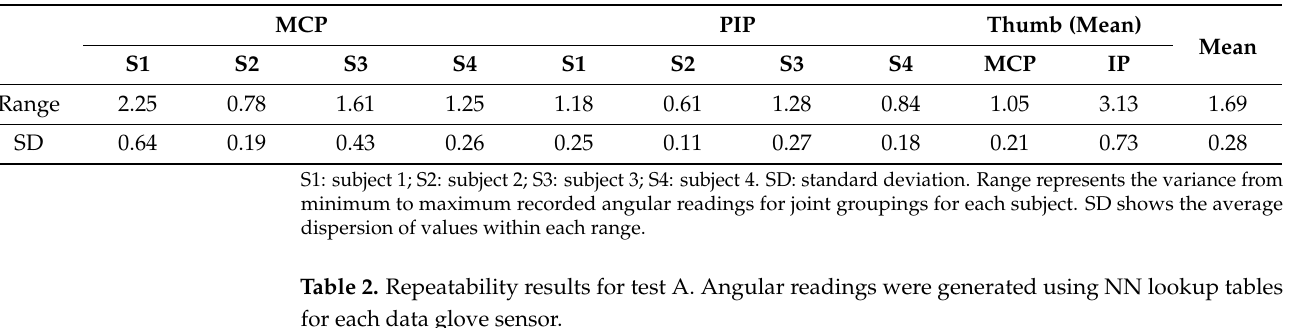
Table 1. Repeatability results for test A. Angular readings were generated using data collected from each data glove sensor.